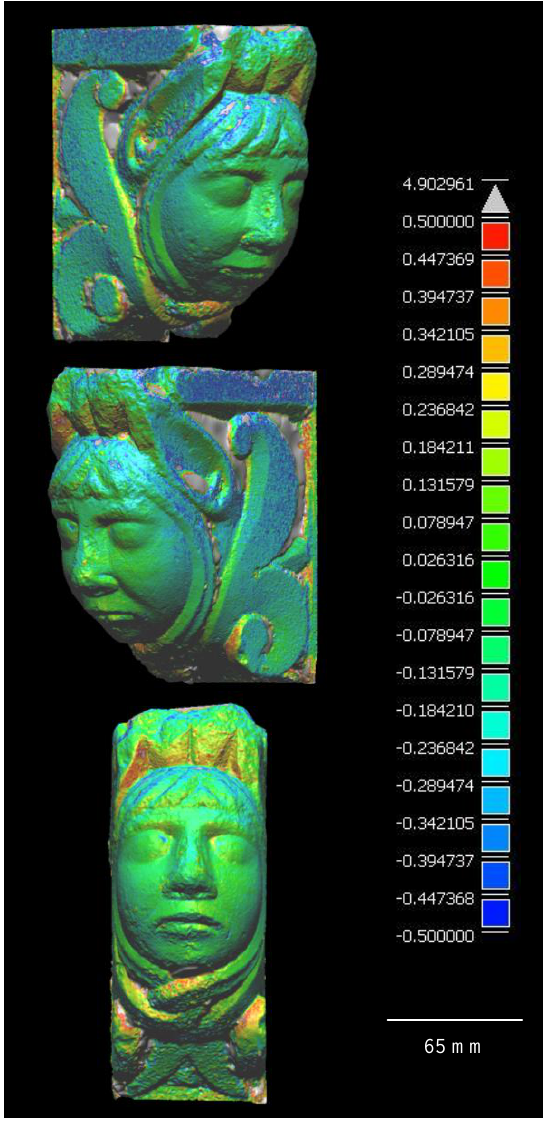
Figure 7. Comparison between the corbel 3D model (Tapas- derived) and the “ground-truth” data: deviation map (mm) Figure 7 shows three views of the deviation map obtained from the comparison between the Tapas-derived 3D model and the “ground-truth” data, for the corbel test-object. The colour scale ranges from -0.5 mm (blue) to 0.5 mm (red): this distance interval is chosen in accordance with the standard